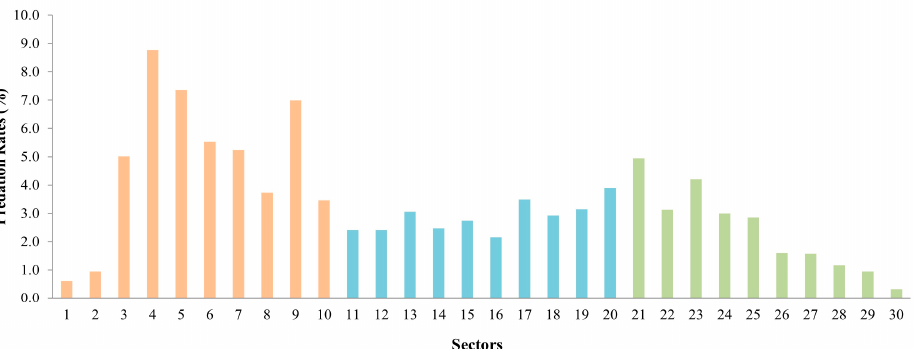
Figure 4. Percentage of predated nests per sector in Corozalito, from 2008 to 2021; Northern Area (orange) = sectors 1–10, Central Area (blue) = sectors 11–20, Southern Area (green) = sectors 21–30.